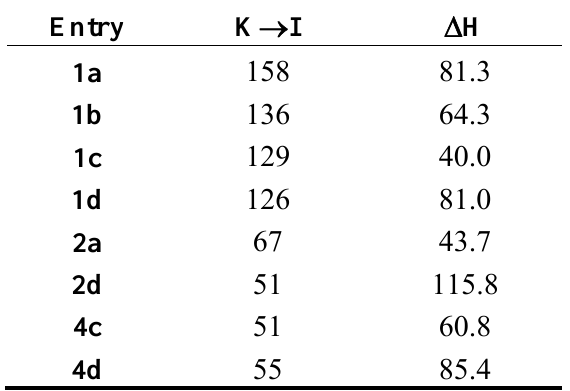
Table 1. Transition temperatures (onset values) (  C) and enthalpy values  H